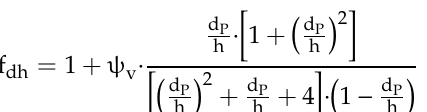
12 of 30 Figure 8. Schematic simplified representation of shear increase due to solid particles. η (cid:2928)(cid:2915)(cid:2922) = (cid:2967) (cid:3207)(cid:3180) (cid:2967) (cid:3116) (48)